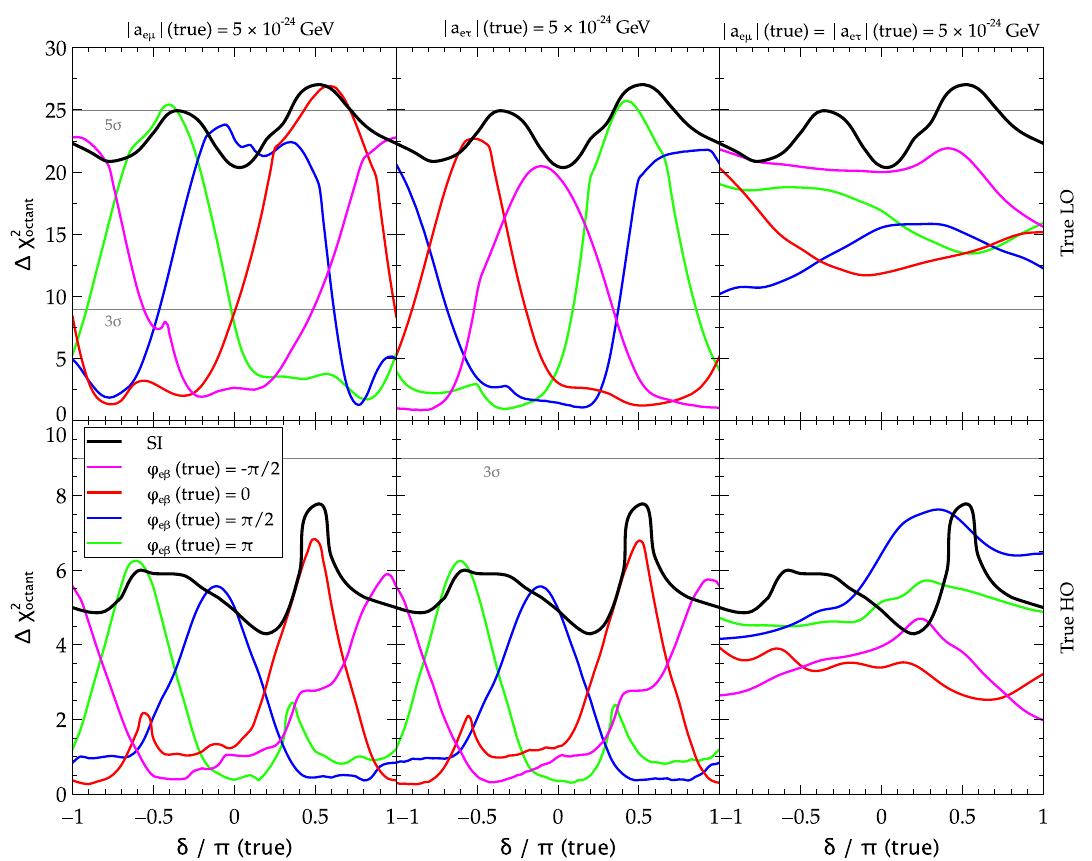
Fig. 3 Discovery potential of the true octant as a function of true δ . In top (bottom) panels, we assume NO-LO (NO-HO) as the true choice = 42 . 3 ◦ (47 . 7 ◦ ) as benchmark value for LO (HO) case. The with θ true 23 left (middle) panels are for the individual LIV parameter a e μ ( a e τ ), while the right panels deal with the case when both the LIV parame- ters are present simultaneously. In each panel, the black curve shows the result for the SI case, while the four colored lines depict the sen-